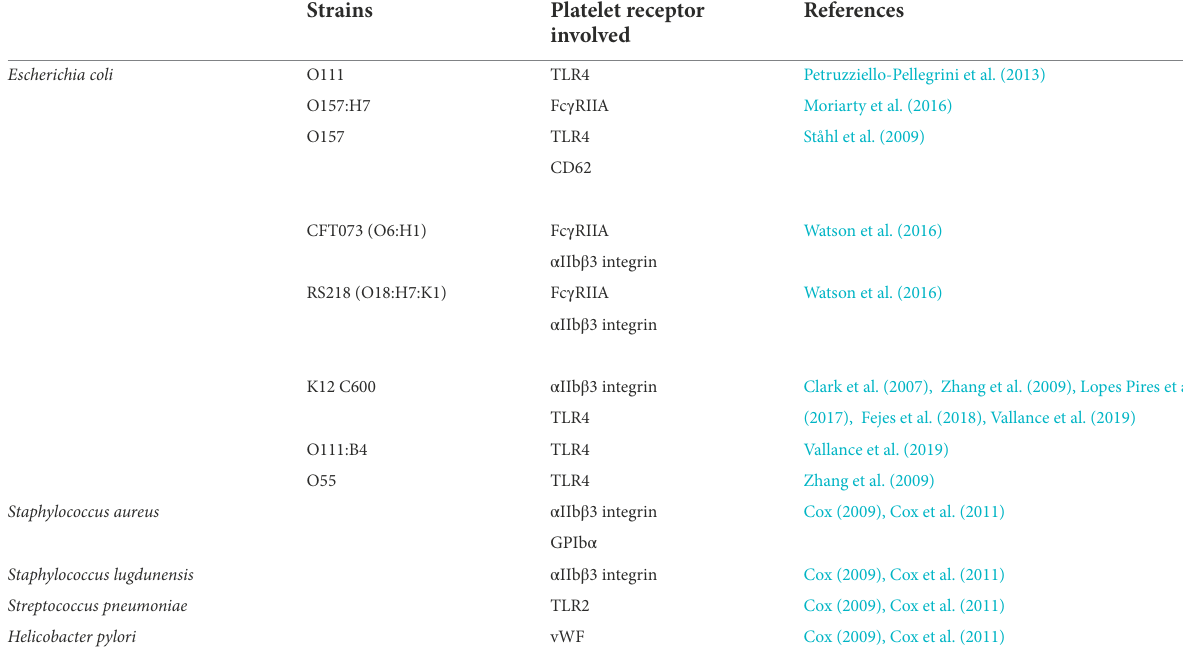
TABLE 1 Summary of data available in the literature concerning interactions between bacteria and platelets. Strains Platelet receptor